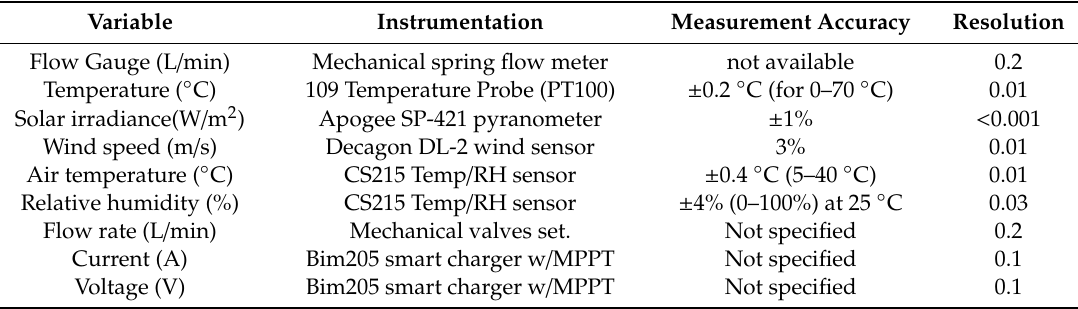
Table 2. Test Variables and